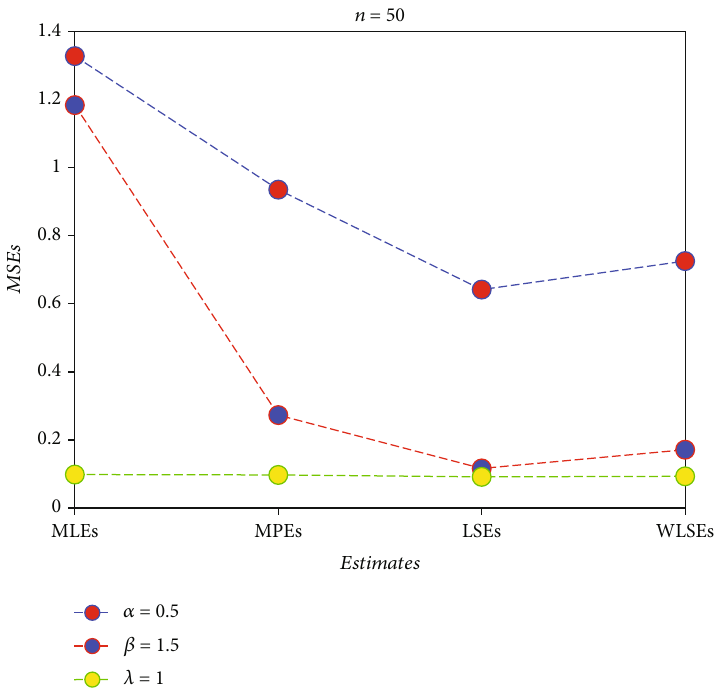
Figure 5: MSEs using n = 50 : α = 0 : 5 , β = 1 : 5 , and λ = 1